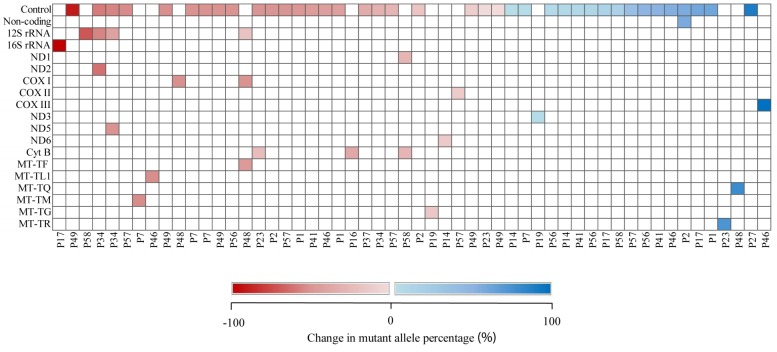
Shifts in the variant allele percentage of heteroplasmic germline variants.Each coloured rectangle corresponds to a heteroplasmic germline mutation (white = no heteroplasmy present, red = decreases in mutant allele percentage from normal to tumour, blue = increases in mutant allele percentage from normal to tumour). The shifts in heteroplasmy are presented in tabular format in S4 Table. Adapted from [34].